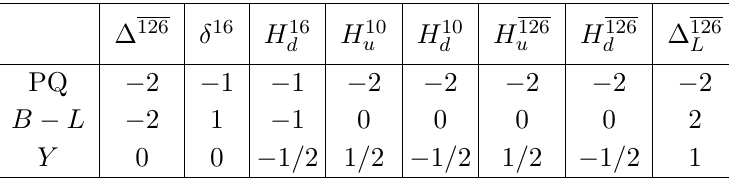
L and Y ) charges of the SO(10) sub-multiplets hosting the (cid:0)